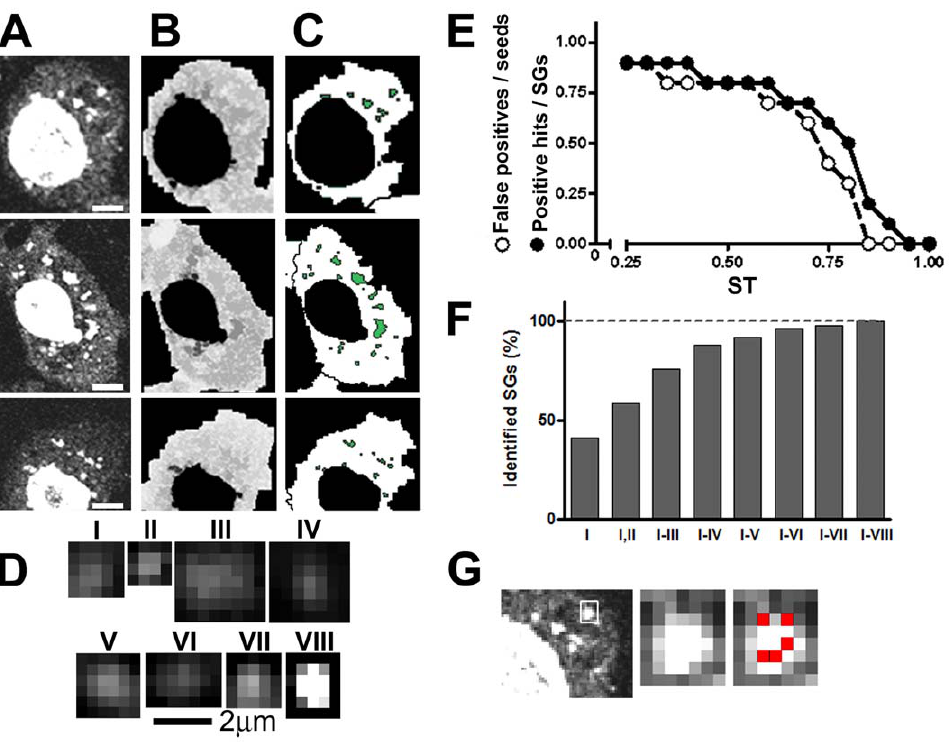
Figure 1. SGs in Drosophila S2R + cells and script summary. Cells were grown, treated and stained in 384 MW plates as indicated in Materials and Methods. A, B and C, Three representative cells are shown. A, The oligodT-Cy3 allows the visualization of SGs in the cytoplasm and of accumulated polyadenylated RNA in the nucleus. B, Merged image created by MATLAB before application of the Watershed transform algorithm for the identification of cell border and nucleus. C. Objects were identified as SGs by correlation with the selected prototypes using the MATLAB normxcorr2 function. D, Prototypes used to identify and analyze SGs. These were selected among 50 different examples to include differences in size, shape and intensity pattern. Size bar, 2 m m. E and F, A collection of 6 micrographs containing 125 cells with a total of 282 granules (see Table 1) were used to investigate the effect of varying the similarity threshold (ST) and of increasing numbers of prototypes. E, The proportion of false positives relative to the number of seeds and the proportion of positive hits relative to the manual-counted number of SGs was measured at different ST for the prototype IV, depicted in D. An ST of 0.85 allowed no false positives. SG recognition dropped from 80% to 20% at this ST value, and similar values were observed for the other prototypes (not shown). F, The number of positive hits that resulted by correlation with the indicated prototypes subsets was measured. All the SGs present in the micrographs were identified with the six prototypes depicted in D. Size bar, 5 m m. G, A representative SG from the cell in the first row showing the seeds (red) created by the script.